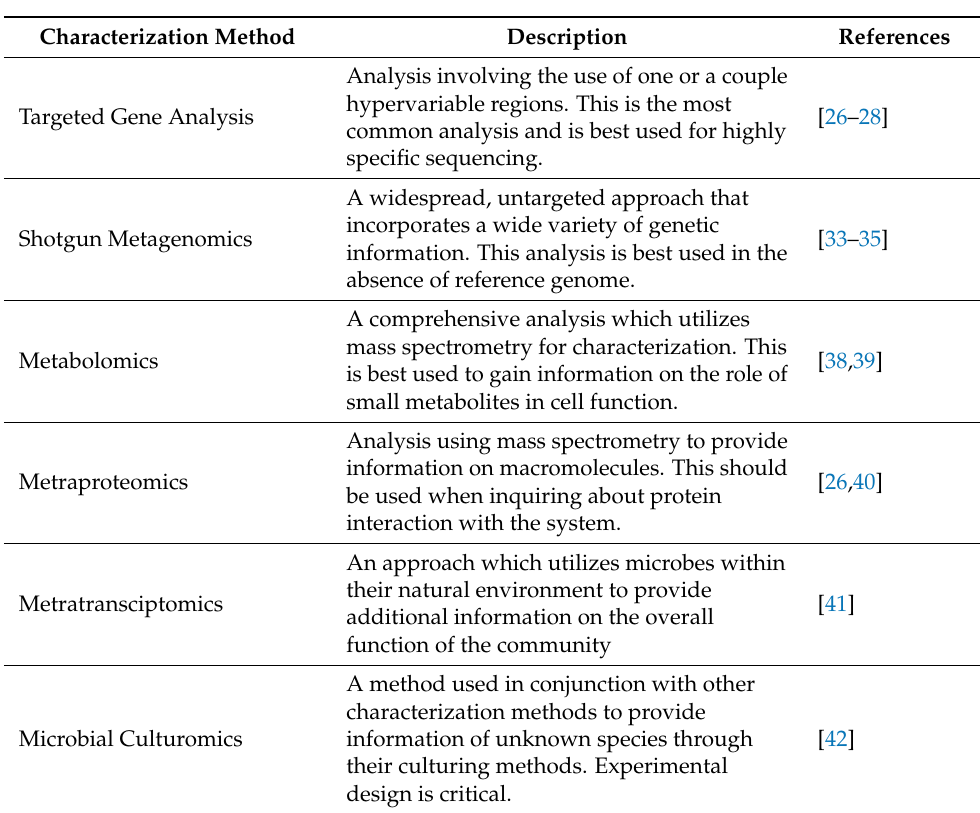
Table 1. A comprehensive description of the main microbiome characterization methods and applica-